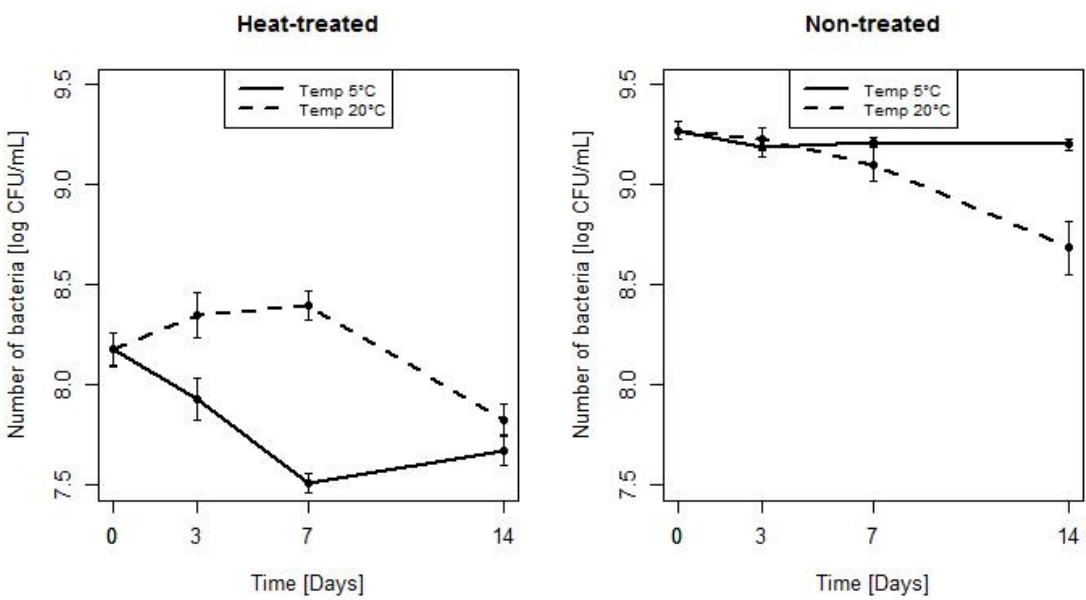
Figure 4. The changes of the mean number of HT and NT bacteria stored at 5 and 20 °C (error bars represent standard errors of the mean).